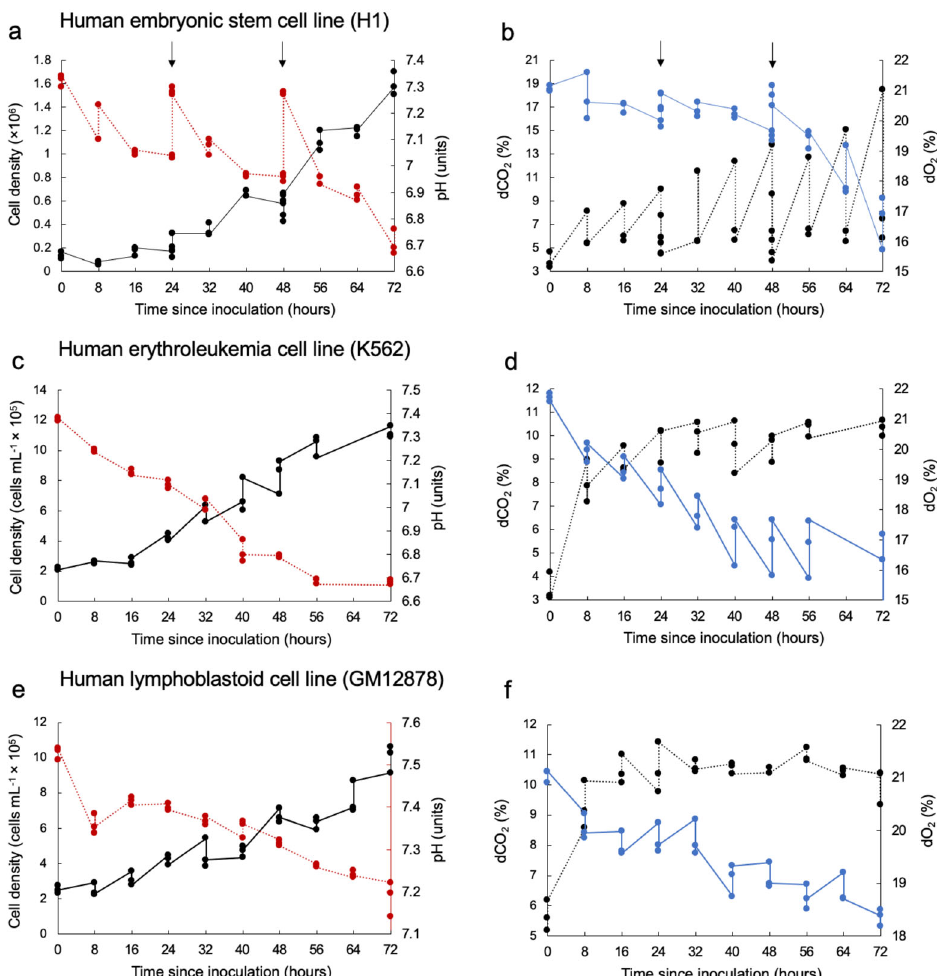
Fig. 2 Measured environmental conditions in human cell cultures. a Time course of cell density (black data points) and medium pH (red data points) in cultures of human embryonic stem cells (H1 hESC, seeding density 1.8 × 10 5 in T25 fl asks with a growth area of 25 cm 2 and working volume of 5 mL). b Time course of dCO 2 (black data points) and dO 2 (blue data points) in cultures of H1 hESC. Medium buffered with 5% CO 2 /22 mM HCO 3 − plus 15 mM HEPES. Arrows in panels ( a ) and ( b ) represent the timing of 24 h medium exchanges for the H1 hESC cell line. c Time course of cell density (black data points) and medium pH (red data points) in cultures of human erythroleukemia cells (K562, seeding density 2.0 × 10 5 mL − 1 in T75 fl asks with a growth area of 75cm 2 and working volume of 20 mL). d Time course of dCO 2 (black data points) and dO 2 (blue data points) in cultures of K562. Medium buffered with 5% CO 2 /22 mM HCO 3 − . e Time course of cell density (black data points) and medium pH (red data points) in cultures of human lymphoblastoid cells (GM12878, seeding density 2.0 × 10 5 mL − 1 in T75 fl asks with a growth area of 75 cm 2 and working volume of 20 mL). f Time course of dCO 2 (black data points) and dO 2 (blue data points) in cultures of GM12878. Medium buffered with 5% CO 2 /22 mM HCO 3 − . Measurements conducted for three culture fl asks per cell line (three biological replicates each). Data points at each time point represent data for the three biological